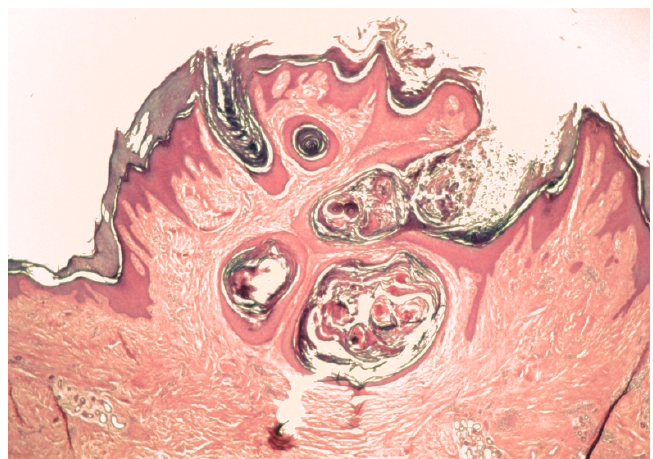
Figure 3. An involuting tumor with cornified “nests” coalescing into a keratin plug in the